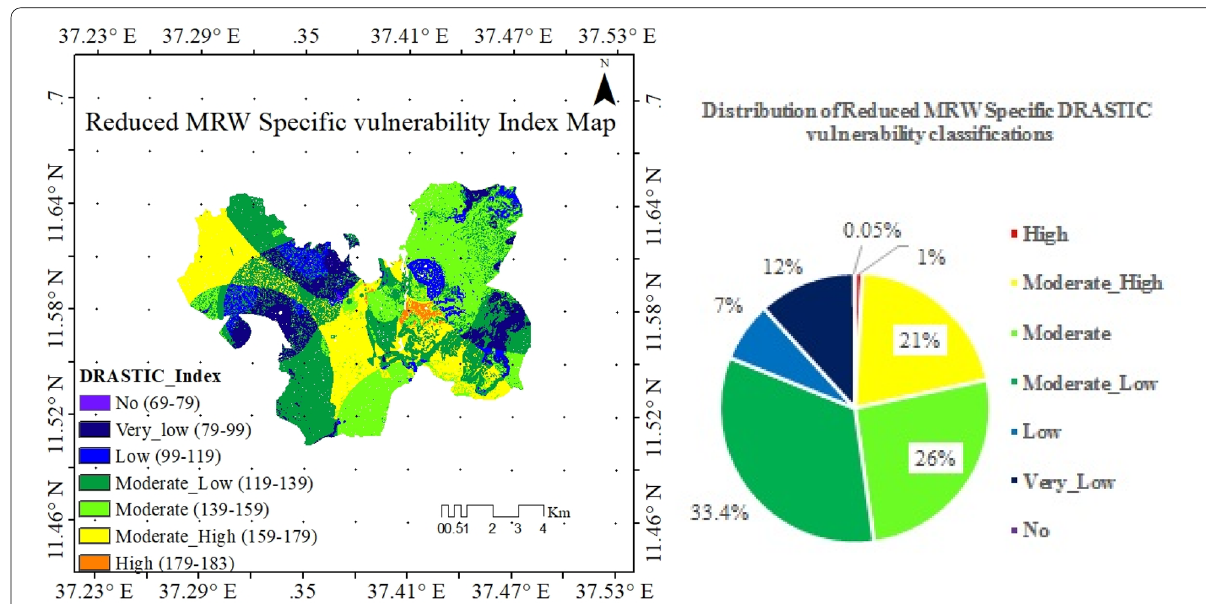
Fig. 11 Reduced modified rate and modified weight (MRW) DRASTIC map (left) and area percentage (right)